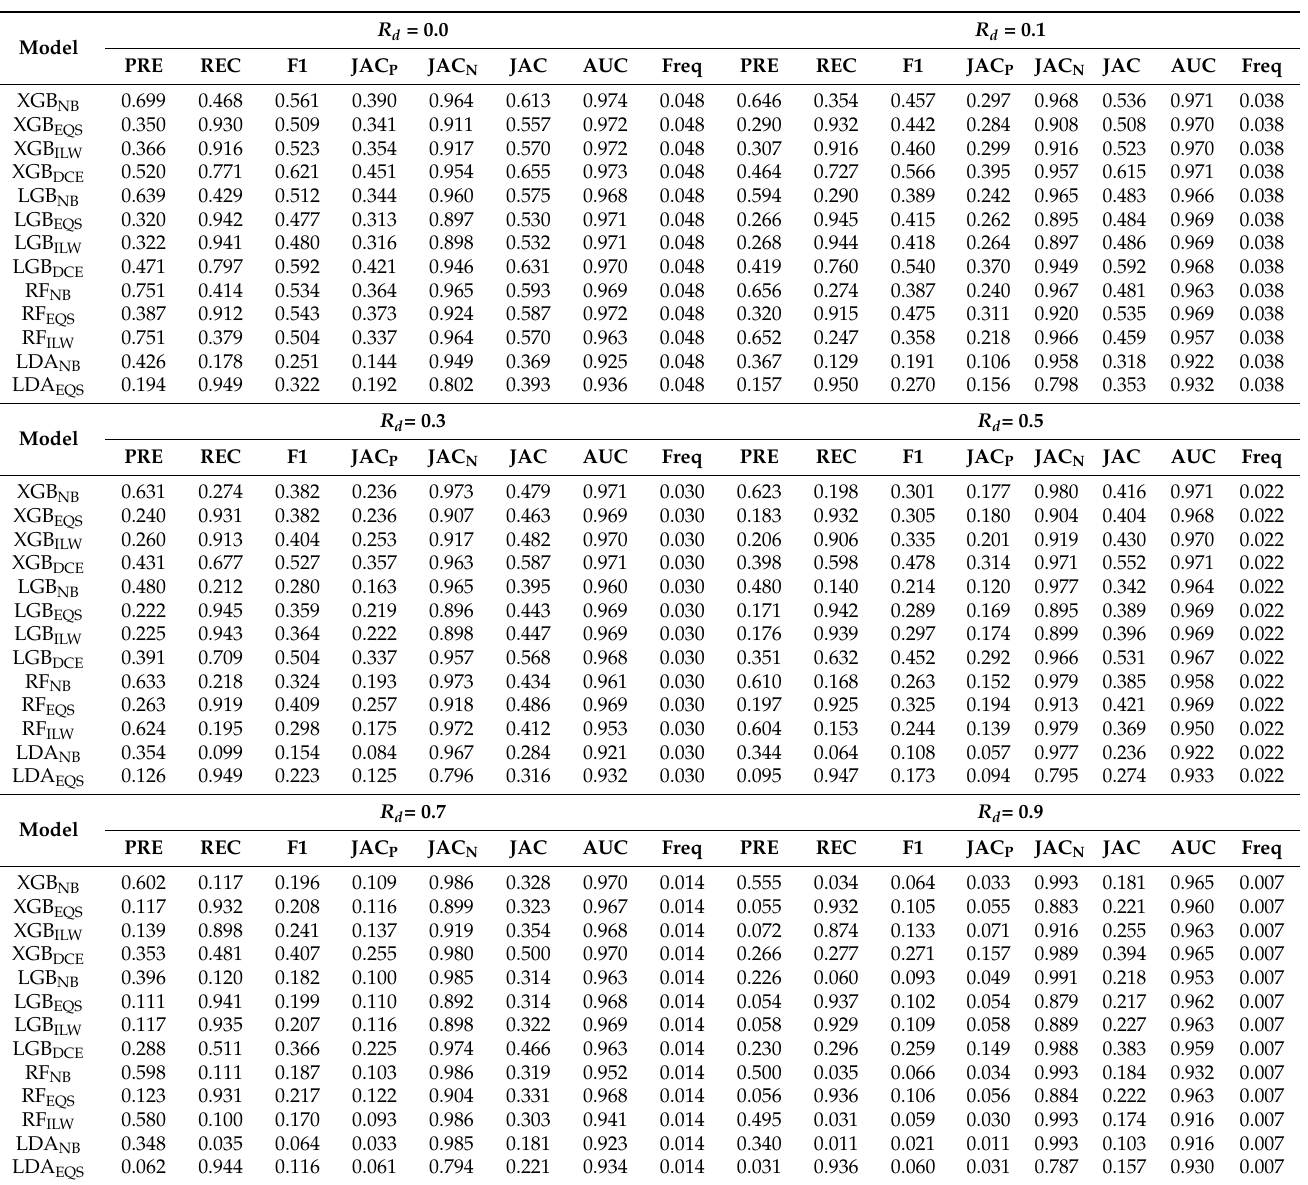
Table 4. Model prediction performance of different landslide features for every